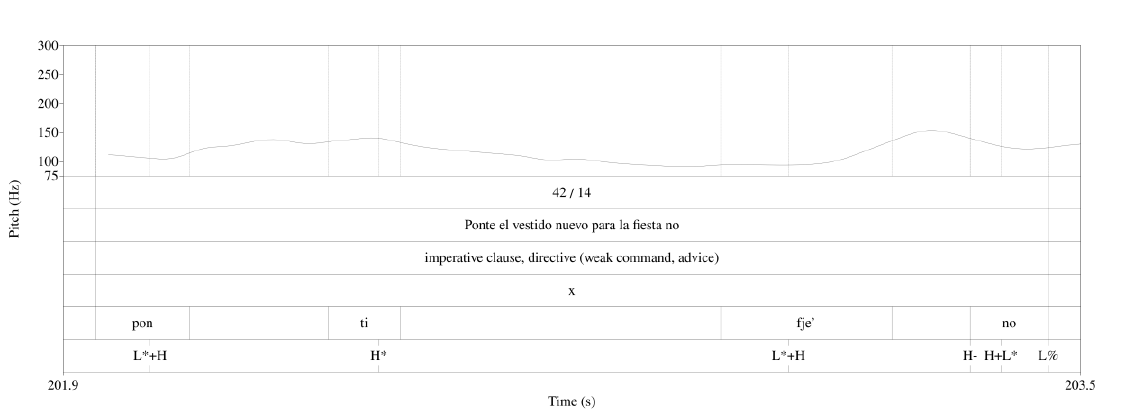
Figure 4. Ponte el vestido nuevo para la fiesta, ¿no? realized with a falling contour over the tag